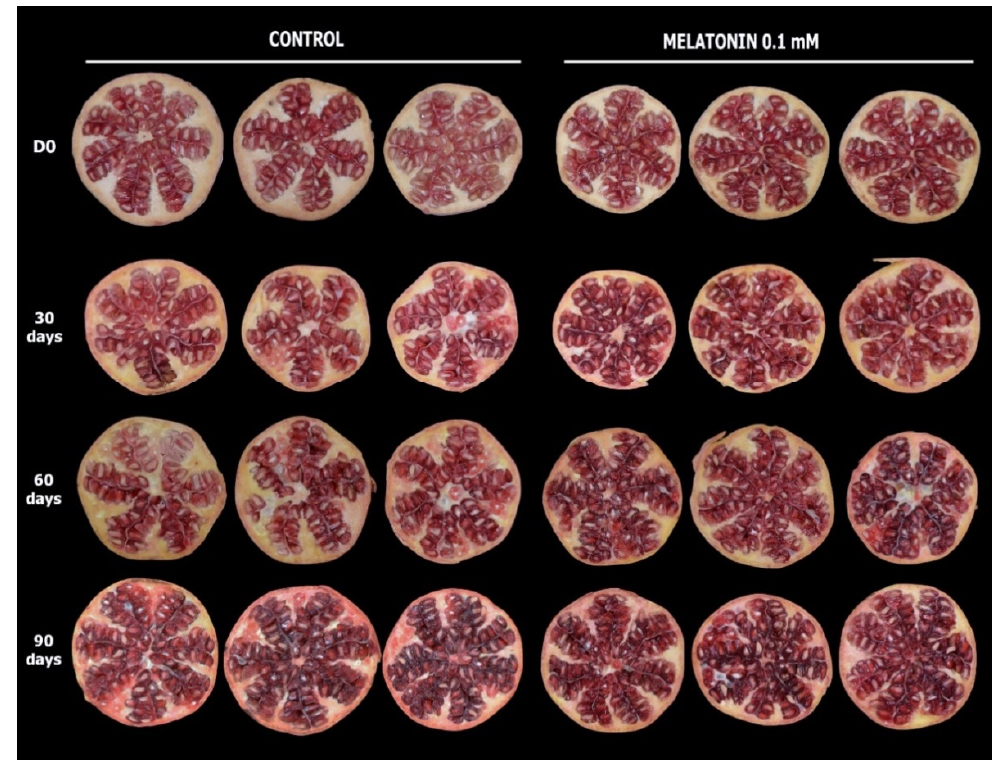
Figure 3. Photography displays the visual aspect of pomegranates from control and 0.1 mM melatonin-treated trees during storage in the 2018 experiment.